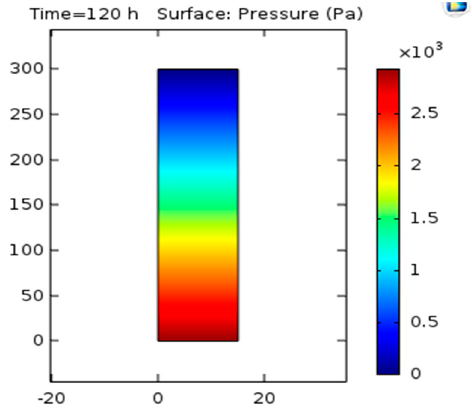
Figure 10. Pressure contour in two-dimensional mode.